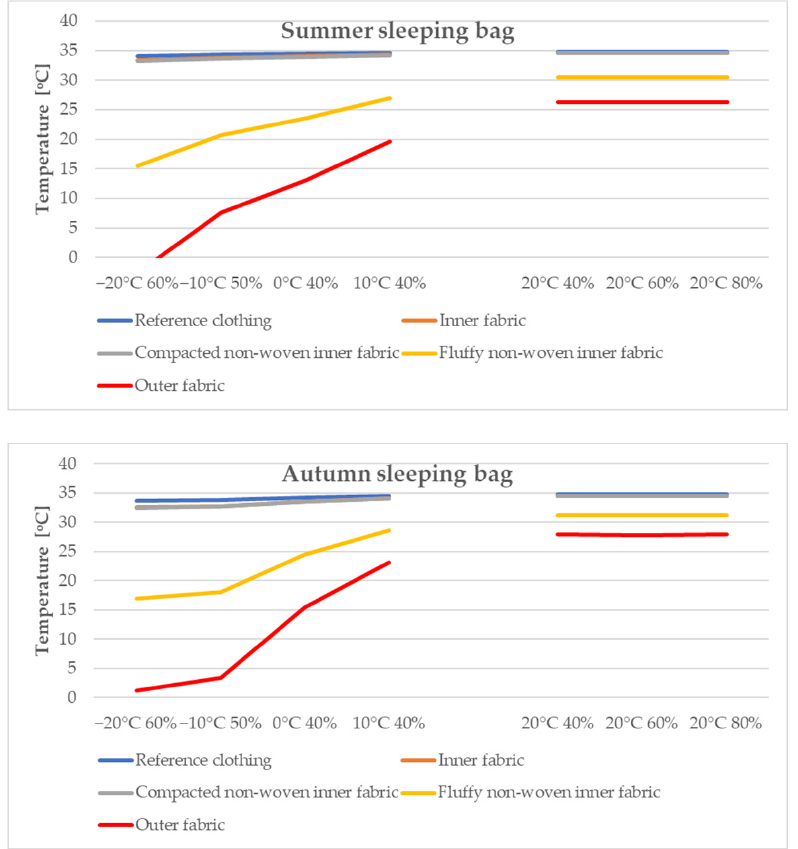
Figure 8. Summary of average temperatures obtained during computer simulations in individual zones of the tested sleeping bags.